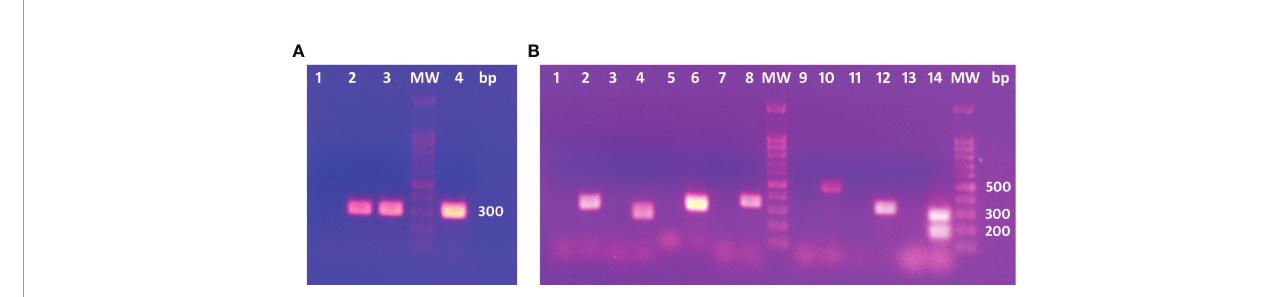
FIGURE 2 | (A) PCR products in electrophoresis agarose gel for COX1C primers. 1: No template. 2 and 3: Positive controls. 4: Cow ’ s liver DNA template. (B) Agarose gel electrophoresis for PCR products. 1, 3, 5, 7, 9, 11 and 13: No template controls for each PCR assay. 2: H4-W6ULY2 11-26 . 4: H4-W6ULY2 134-149; 158-173 . 6: H2A-W6U132 262-277 . 8: H2A-W6U0N3 123-138,138-153,170-185 . 10: H2A-W6UJM4 92-107 . 12:H2A-W6UJM4 27-42 . 14: H2A-W6U132 175-190 . H2A-W6U132 175- fi c product with lower 190 shows two bands: the expected product of 281 bp and an unspeci